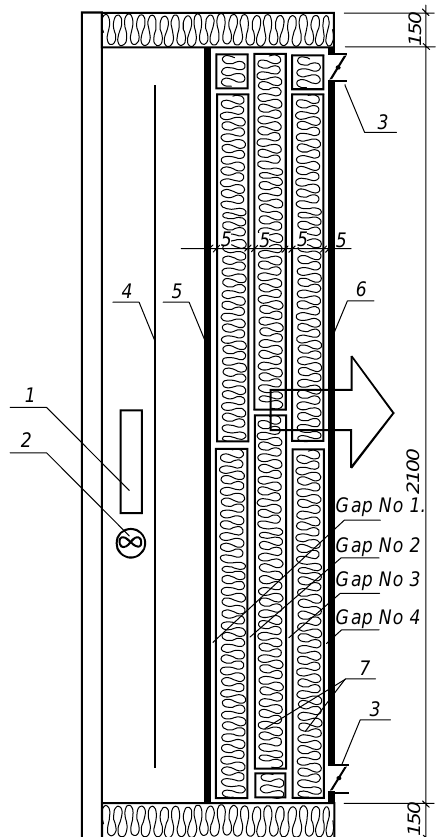
Fig. 6. The scheme of equipment, including a sample: 1 (cid:1) heater; 2 (cid:1) ventilator; 3 (cid:1) ventilation orifices; 4 (cid:1) protection from radiation; 5 (cid:1) warm slab; 6 (cid:1) cold slab with measuring sensors of heat flow density (8 units); 7 (cid:1) polystyrene foam